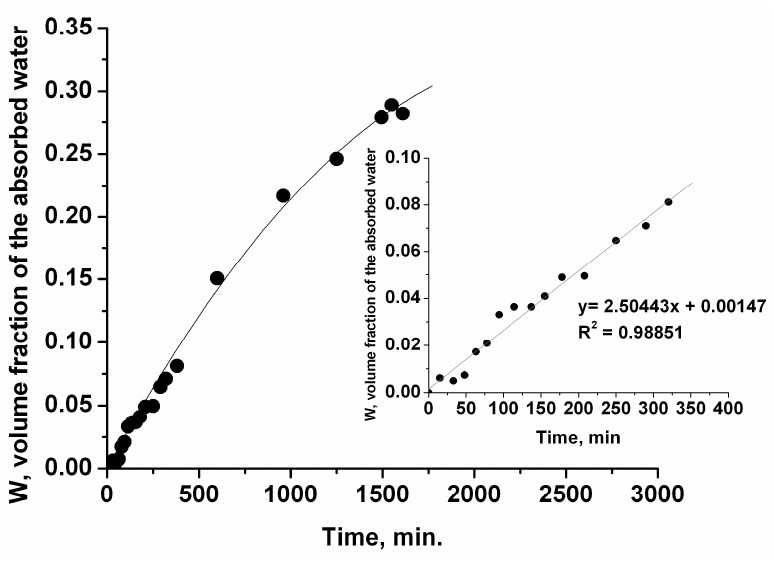
Figure 14. Dependence of the membrane water absorption on the immersion time. The detail presents the increase of W in the first 320 min of immersion.